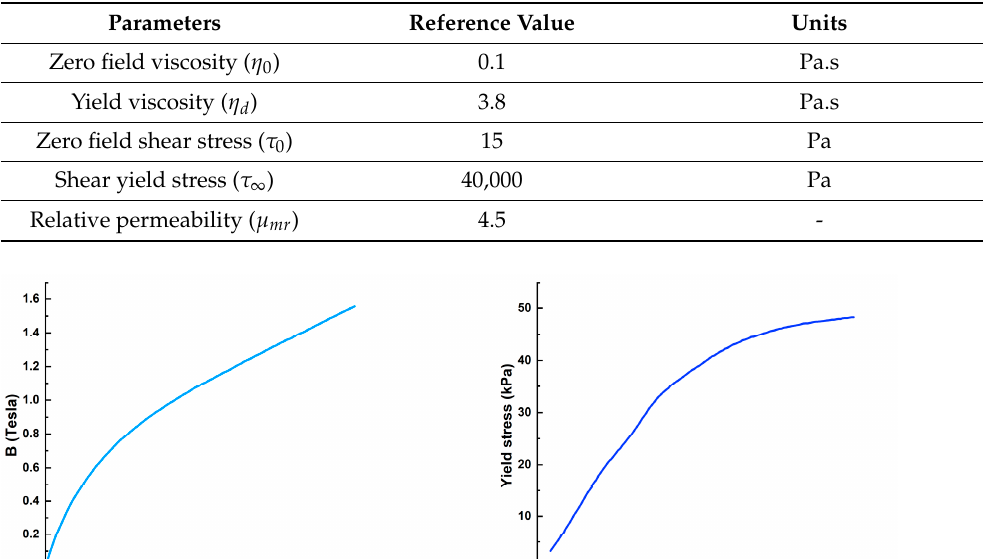
Table 1. Values of fixed parameters of MRF-132DG.